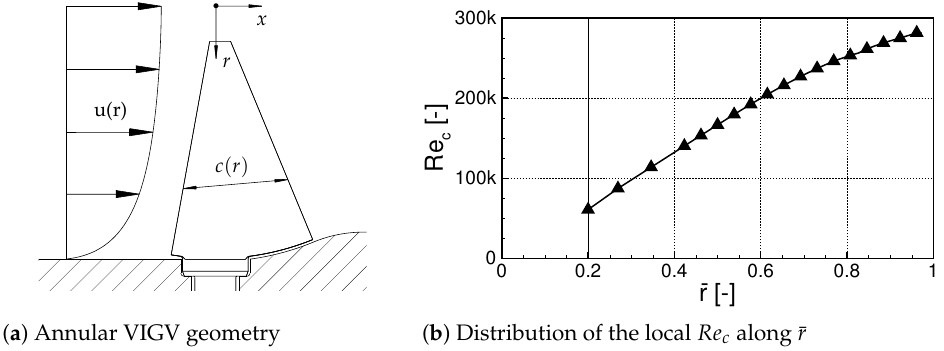
Figure 3. Influence of the tapered blade design and inflow velocity distribution on Re c .